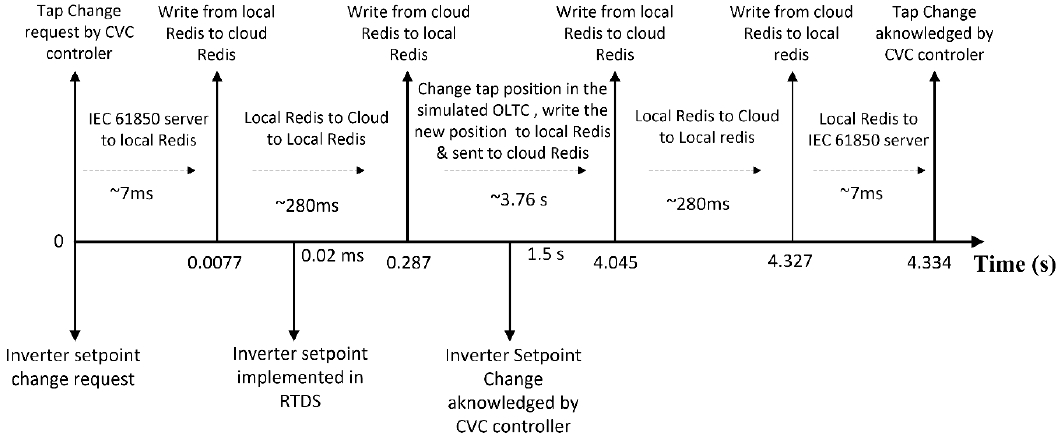
Figure 16. Time delays introduced in the setup.